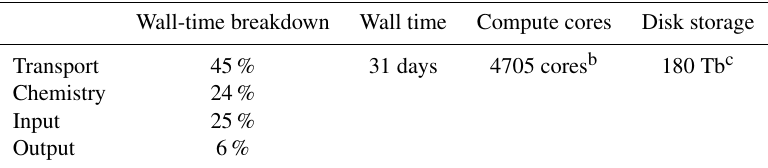
Table A1. Computing resources for the GEOS-5 Nature Run with GEOS-Chem chemistry a